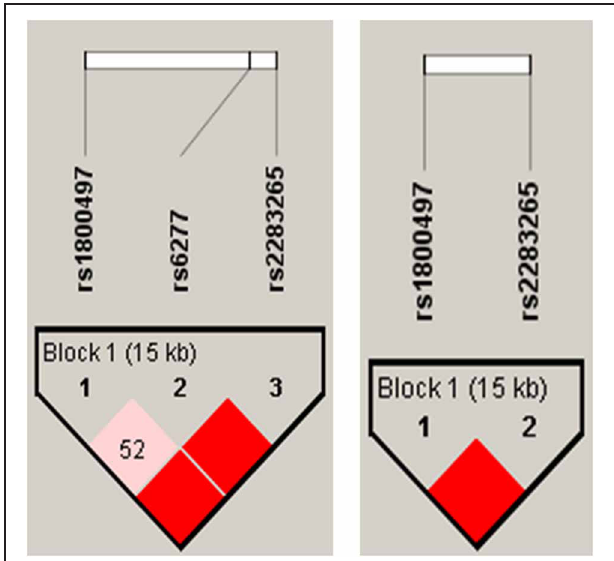
FIGURE 2 | Results of the DRD2/ANKK1 haplotype analyses. Left panel: identification of a three SNP haplotype block using the rather liberal solid spine of LD method. Right panel: identification of a two SNP haplotype block using the more conservative four gamete rule method.